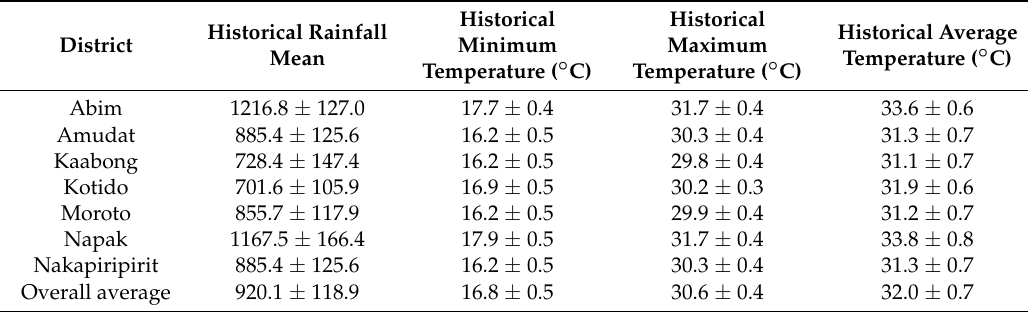
Table 1. Summary of mean historical rainfall, minimum, maximum and average temperature (1980–2009) for Karamoja sub-region. Historical Rainfall District Mean